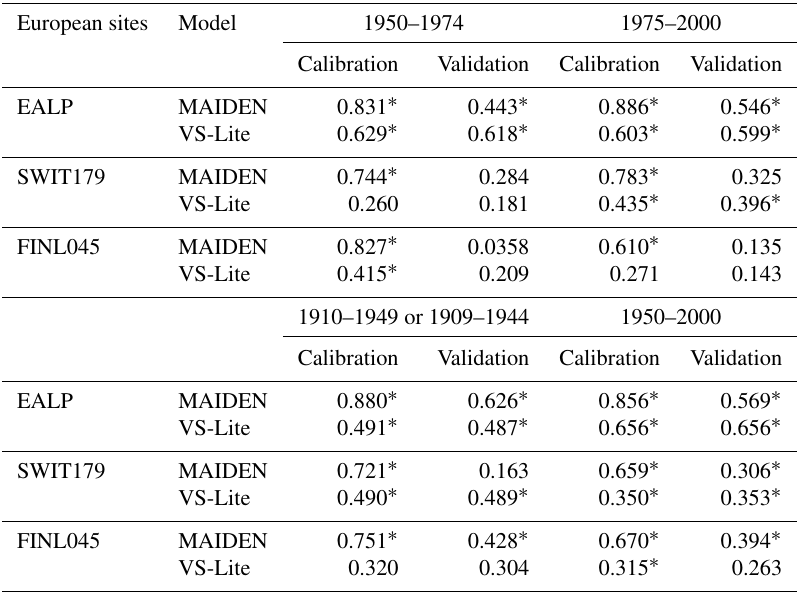
Figure 8. Pearson correlation coefficients between tree-growth observations and simulations at the individual (a) and aggregated Eastern Canadian taiga sites (b) (Fig. 1a and b) with MAIDEN using the NRCAN (5arcmin) climatic dataset (Table 2) with site-specific calibration of the parameters (Orig. calib., in red) and with parameters calibrated based on the mean of the observed TRW time series (Mean calib.) for the 1950–2000 period. White inner circles stand for non-significant correlations ( p value > 0.05). Table 4. Pearson correlation coefficients between tree-growth observations and simulations at the European sites (Fig. 2) with MAIDEN and VS-Lite using GHCN as climatic inputs (Table 2) for the 1950–1974 and 1975–2000 and for the 1910–1949 (EALP, SWIT179) or 1909–1944 (FINL045) and 1950–2000 calibration and validation periods and vice